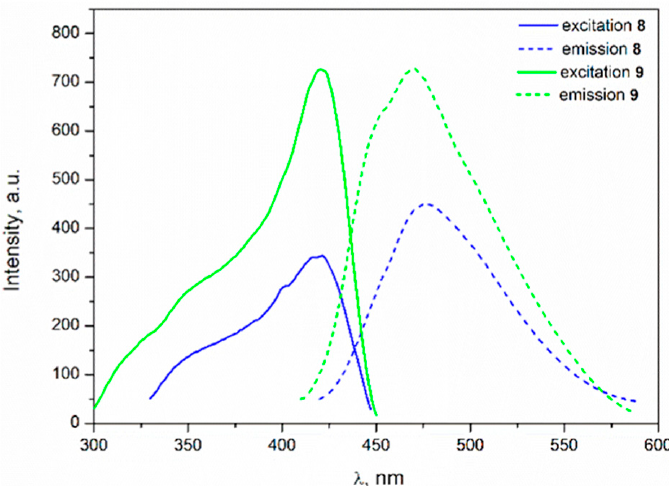
Figure 12. Emission (dotted curves, λ ex = 410 nm for 8 and λ ex = 400 nm for 9 ) and excitation (solid curves, λ em = 475 nm for 8 and λ em = 470 nm for 9 ) for complexes 8 (blue) and 9 (green).